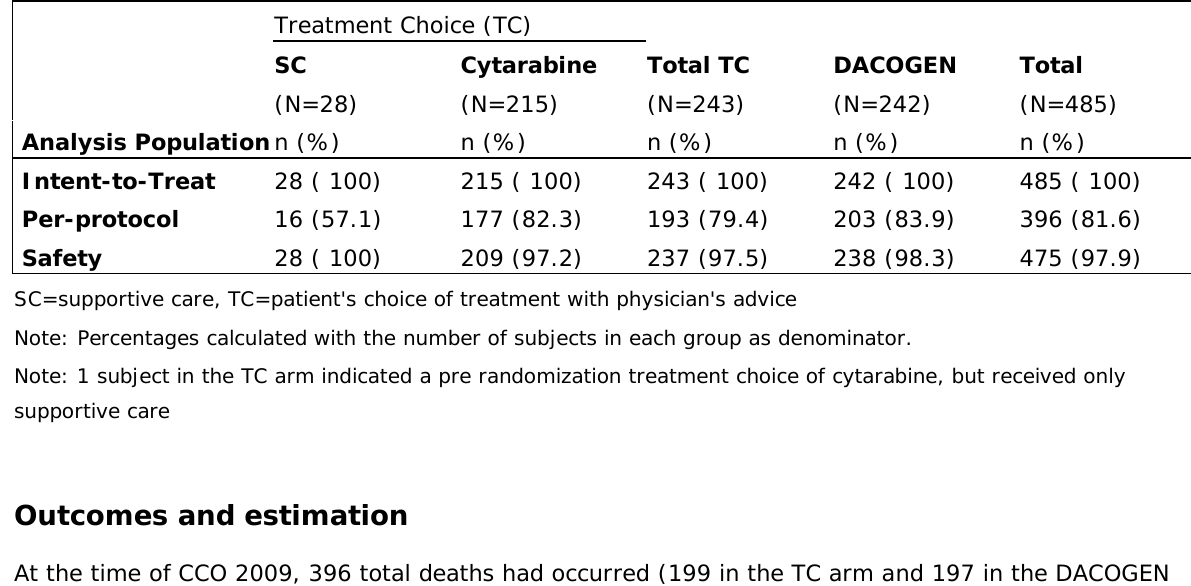
Table 18: Number of Subjects by Population (Study DACO-016: All Randomized Subjects Analysis Set)